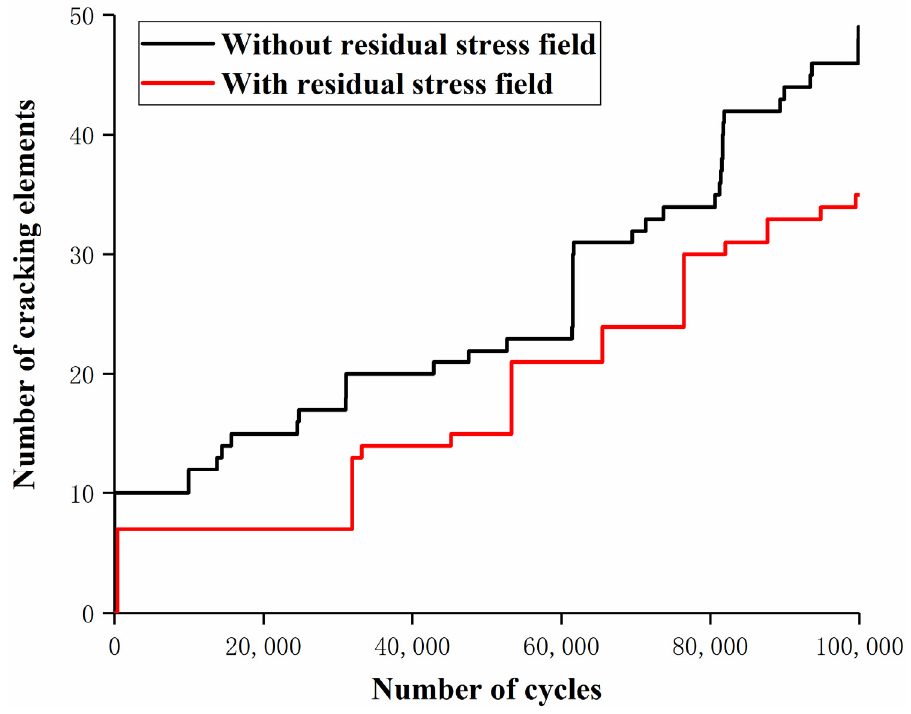
Figure 26. Crack expansion rate when the initial crack is located at the end of the weld.